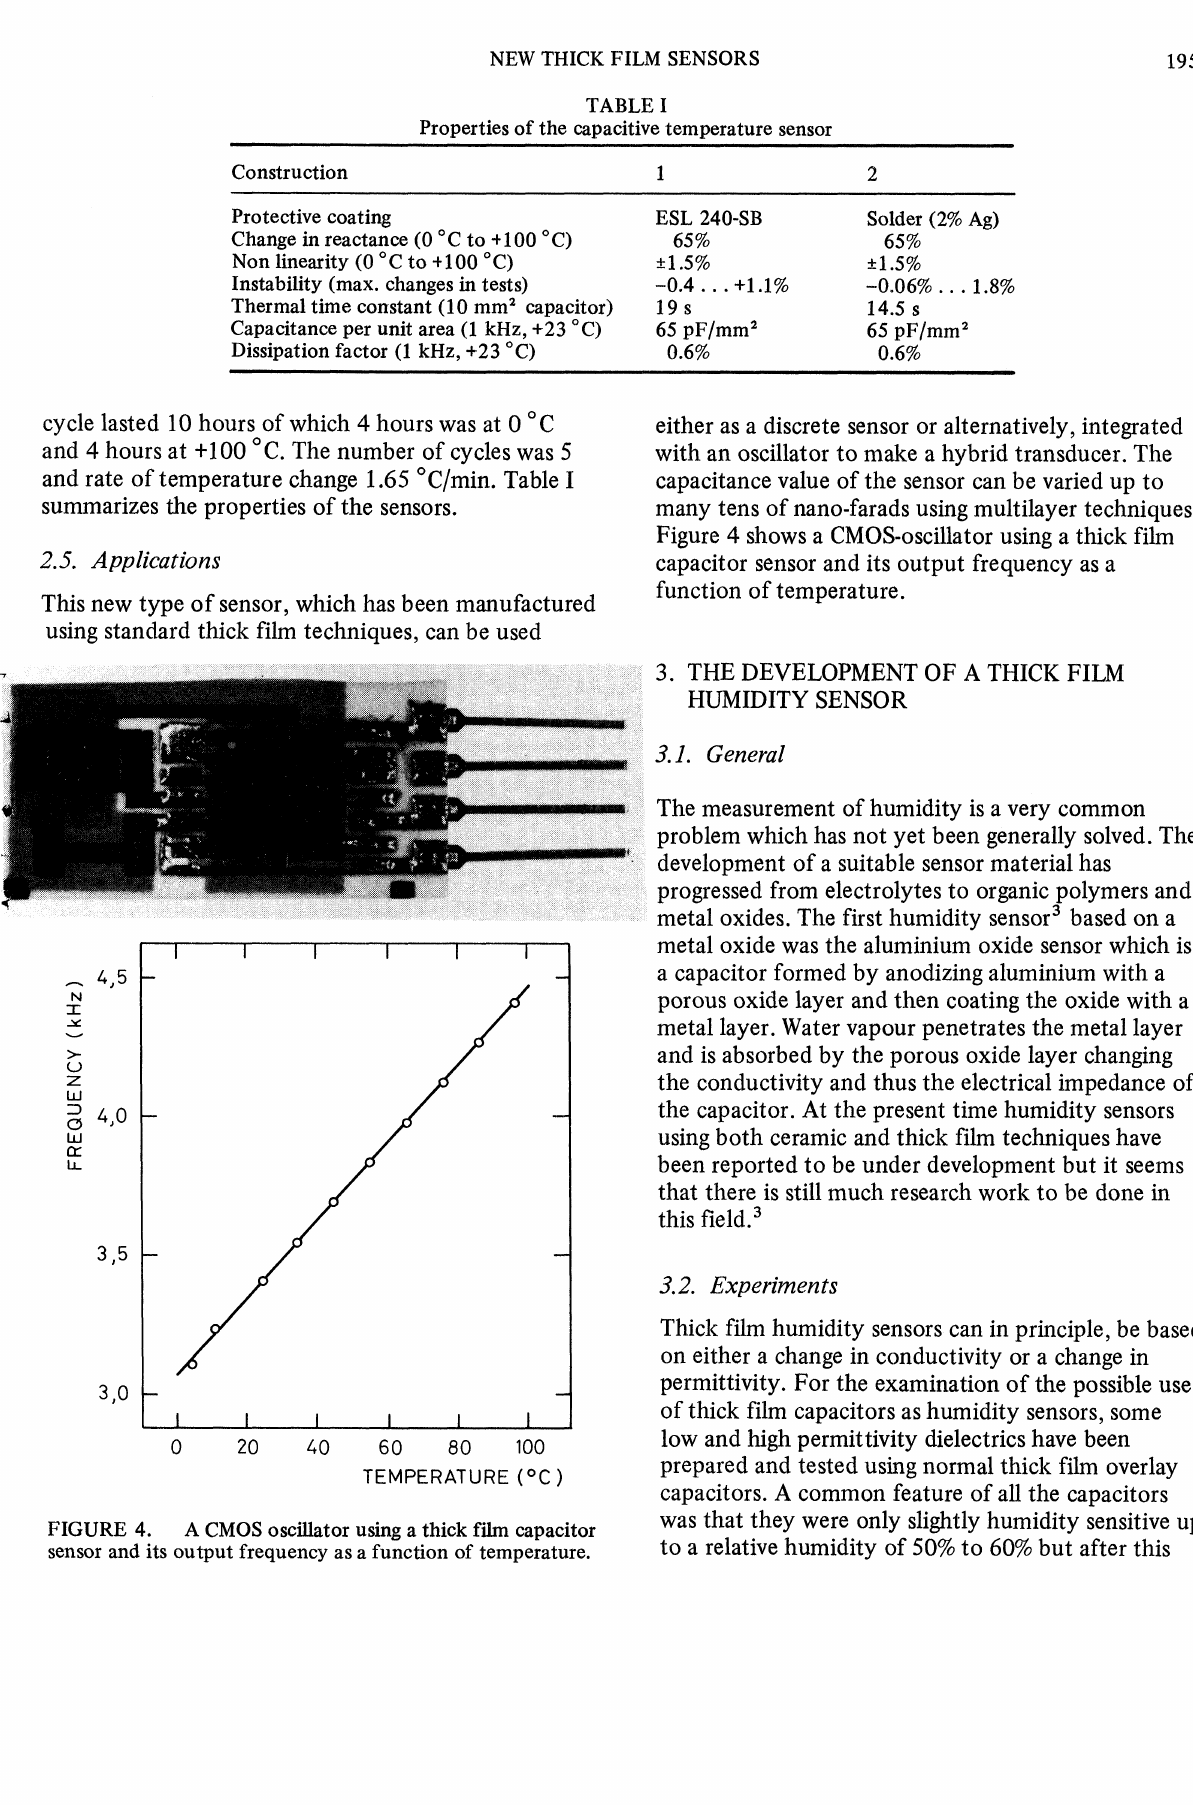
FIGURE 4. A CMOS oscillator using a thick film capacitor sensor and its output frequency as a function of